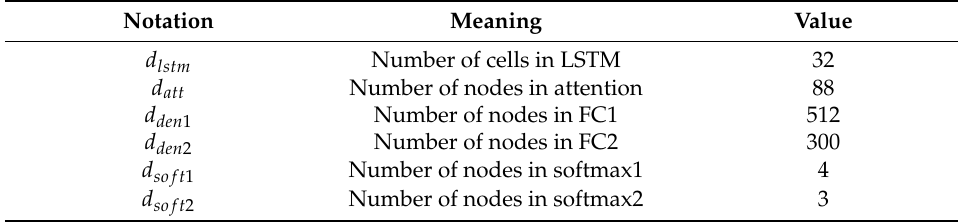
Table 3. Settings of hyperparameters in training.